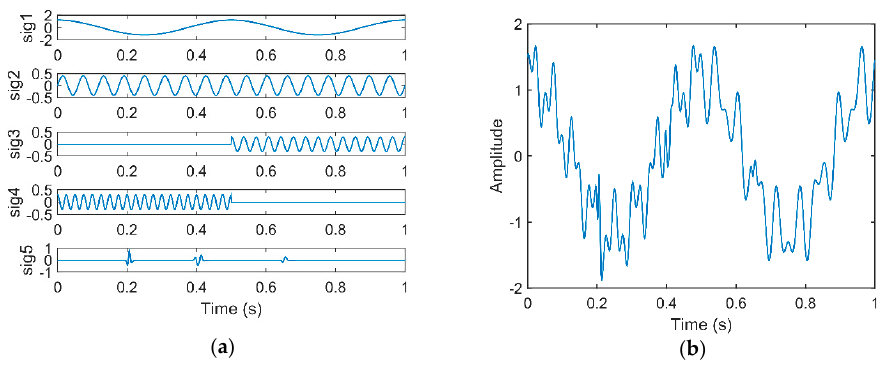
Figure 2. ( a ) Sub-signals; and ( b ) synthetic signal.